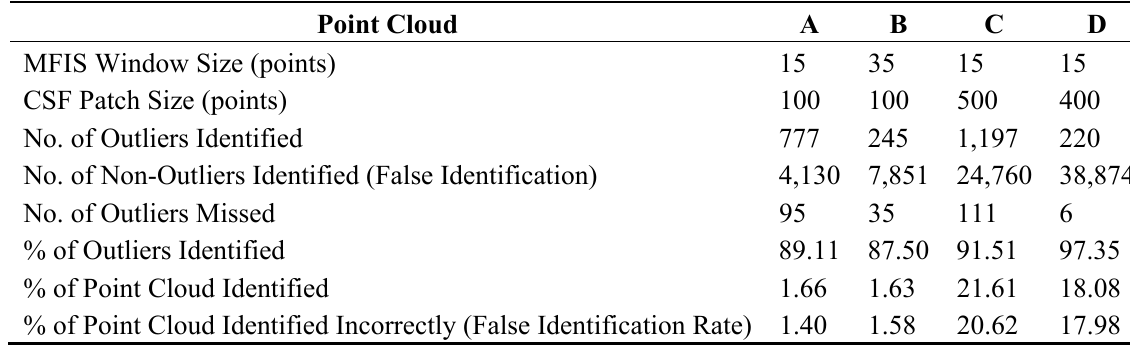
Table 6. Results from trials conducted using the Moving Fixed Interval Smoother (MFIS) preceding Quadratic Polynomial Surface Fitting (CSF) on point clouds A, B, C and D.